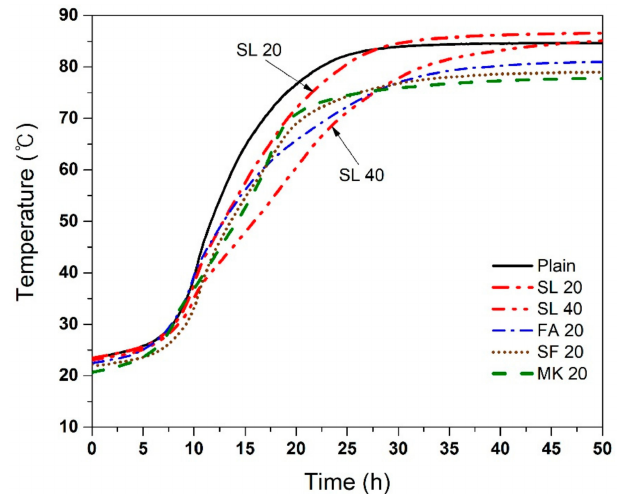
Figure 3. Adiabatic temperature rise of concrete with various SCMs. The difference in the maximum temperature of repeat specimens was generally <3%.